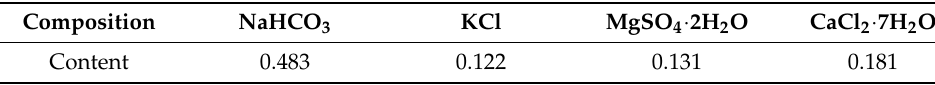
Table 2. Composition of NS4 solution (g/L).